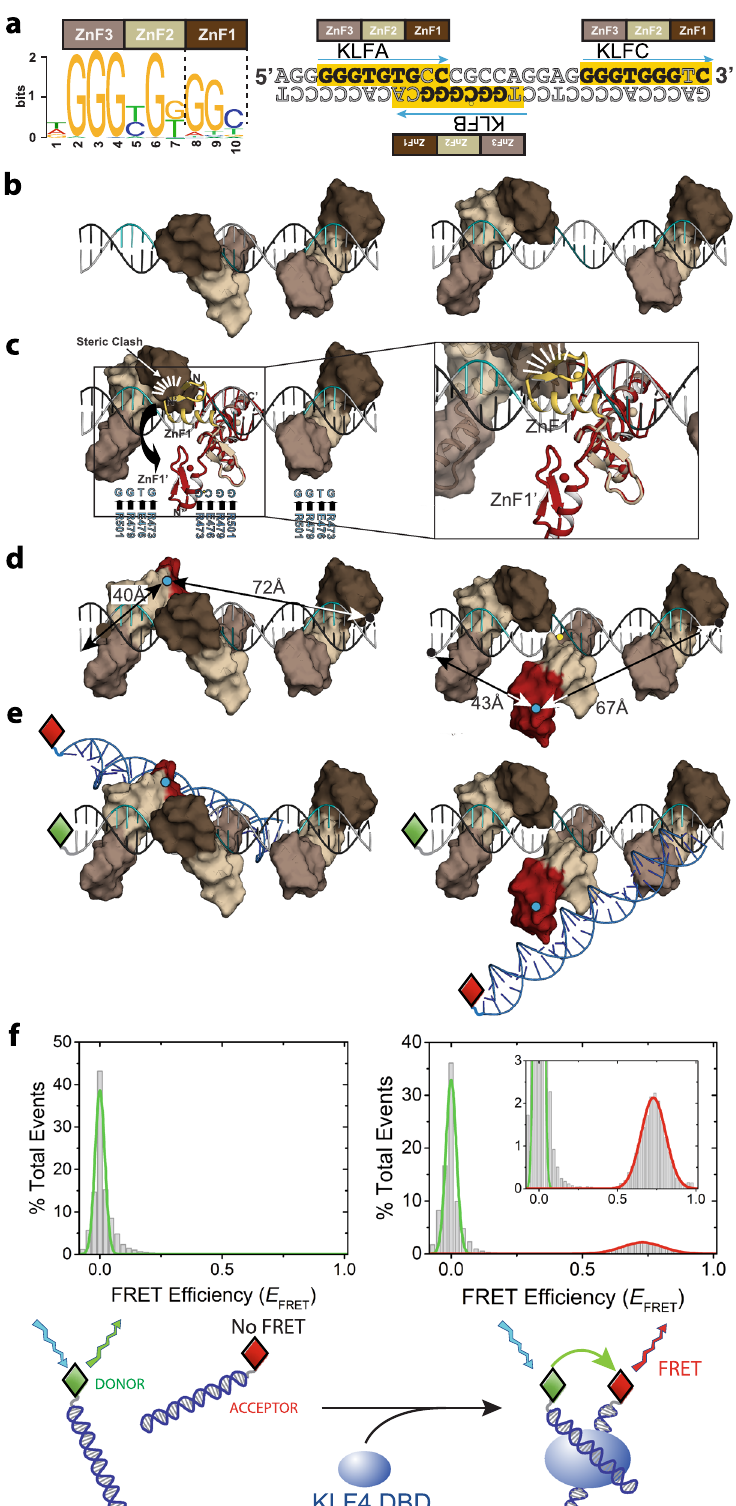
detected at 1.5 µM DBD E476D/R501A , and the thresholds for LLPS at 3.0 and 6.0 µM are 8 fold higher for DBD E476D/R501A than for DBD. Two of the four non-cognate DNAs that condense robustly at 3 µM with 10 µM DBD (Fig. 5a) show no condensation at 3 µM with 10 µM DBD E476D/R501A (Supplementary Fig. 7). We conclude that the ZnF2 and ZnF3 surfaces that contact bases in cognate DNA are important for LLPS with both non-cognate and cognate